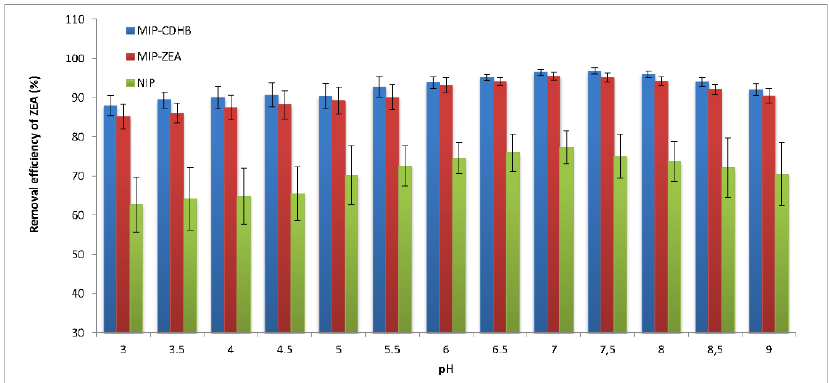
Figure 7. Effect of pH on the adsorption of ZEA onto MIP-CDHB, MIP-ZEA and NIP for the following adsorption conditions: mass of adsorbent = 50 mg, initial concentration = 1 mg · L − 1 , solution volume = 25 mL, T = 298 K.